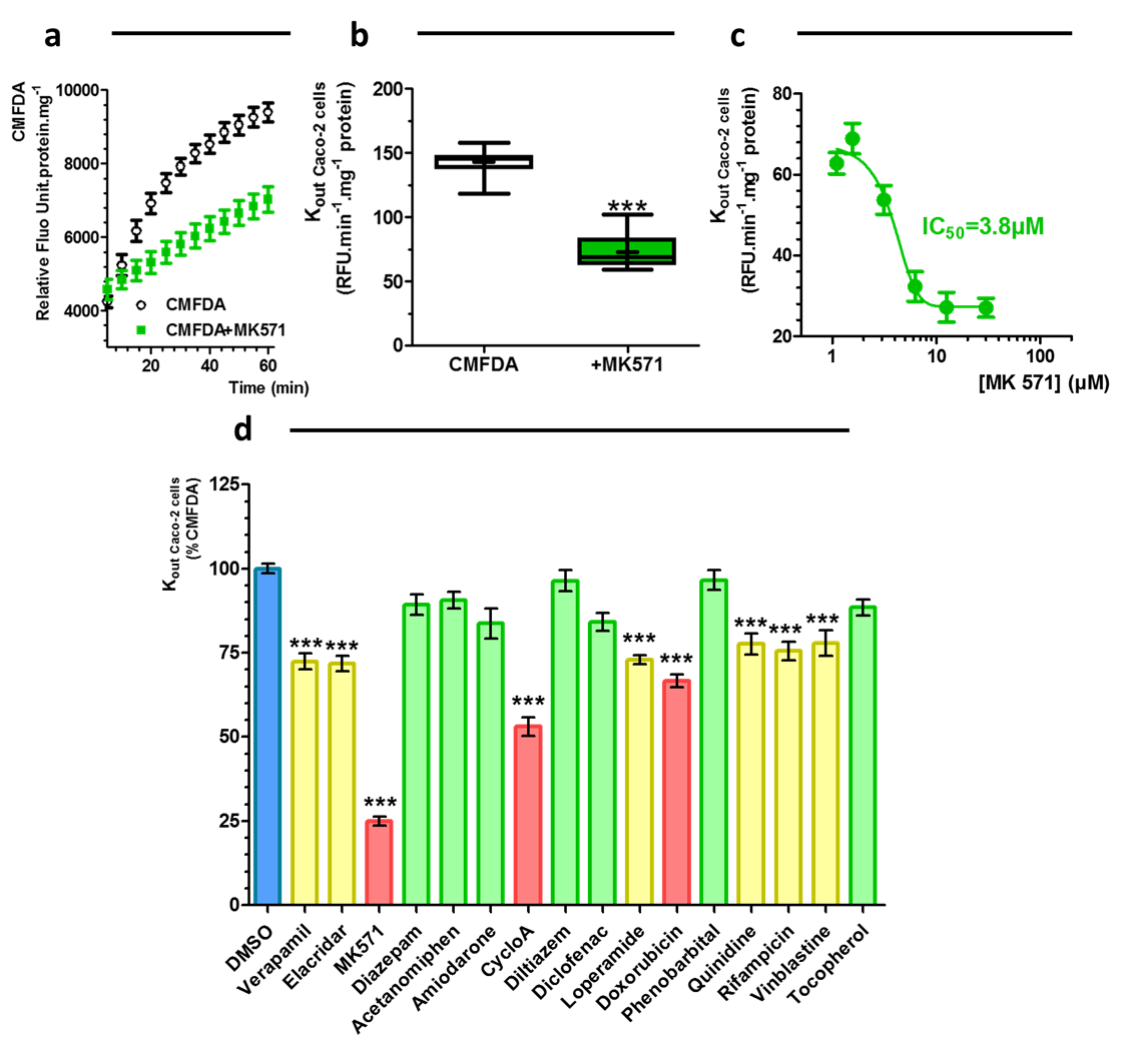
Figure 5. ( a ) Excretion of CMFDA after incubation of cell Caco-2 monolayers in absence or in presence of 50 µ M MK571, (mean ± s.e.m, n = 12). ( b ) Rate of excretion of CMFDA after an incubation of cell Caco-2 monolayers in absence or in presence of 50 µ M MK571 box-and-whisker diagram, whiskers: min to max, mean: cross, n = 12, *** p < 0.001). ( c ) Concentration-dependent e ff ects of MK571 on CMFDA excretion from Caco-2 cells (mean ± s.e.m., n = 12). ( d ) E ff ect of drugs on Rate of excretion of CMFDA (mean ± s.e.m, n = 12–54, *** p <